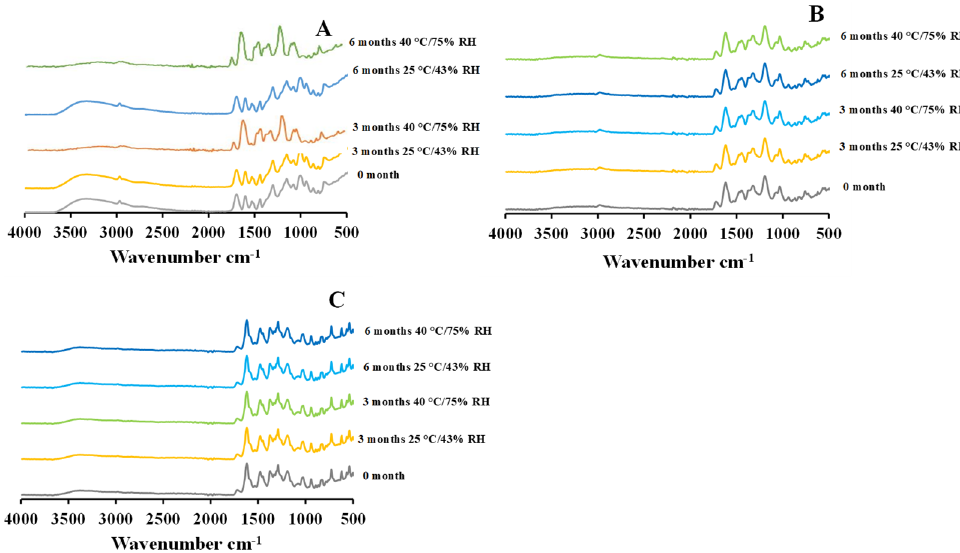
Figure 7. FTIR spectrum of blank and CIP-loaded PEtOx NPs before and after 3 and 6 months of storage at 25 °C/43% RH and 40 °C/75% RH; ( A ) blank PEtOx NPs; ( B ) 5 mg CIP-loaded PEtOx NPs; ( C ) 25 mg CIP-loaded PEtOx NPs. ( C ) 25 mg CIP-loaded PEtOx